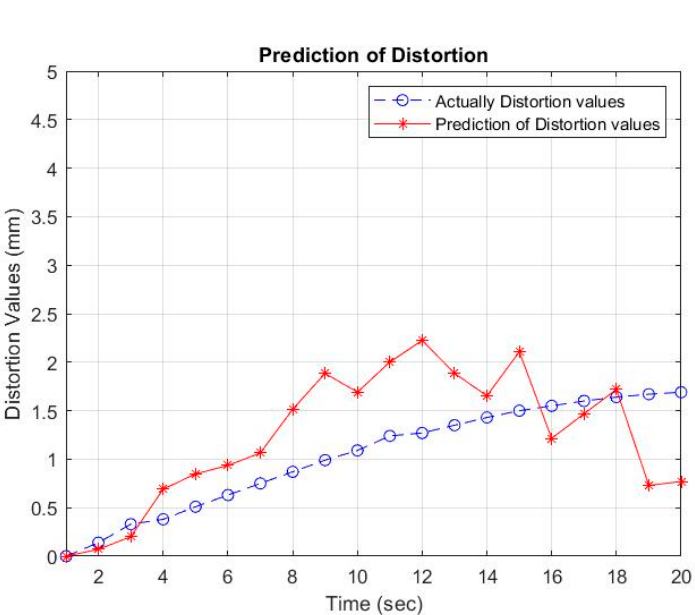
Figure 6. Comparison of predictions and experiments of distortion values at an electrode distance of 18 mm.